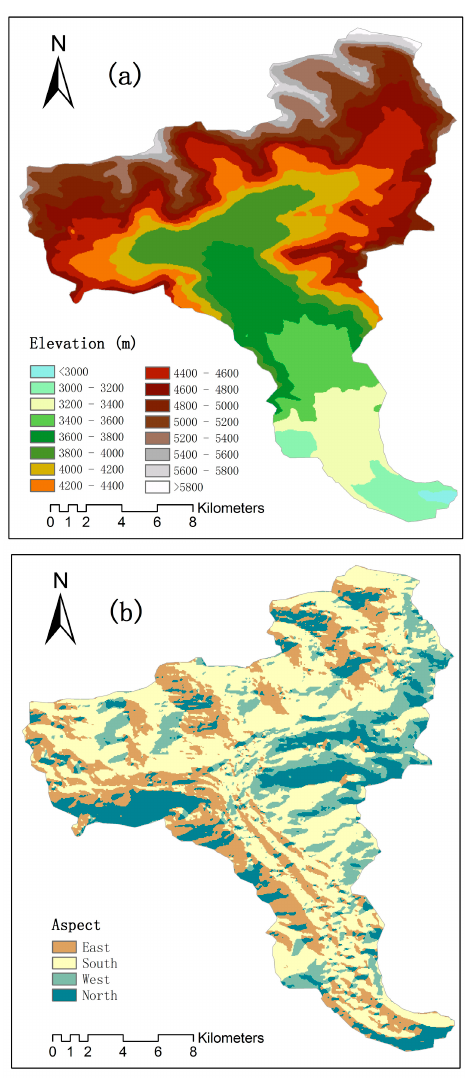
Figure 2. ( a ) Elevation and ( b ) aspect in the Koxkar River Basin. Table 1. Types of vegetation in the Koxkar River Basin.